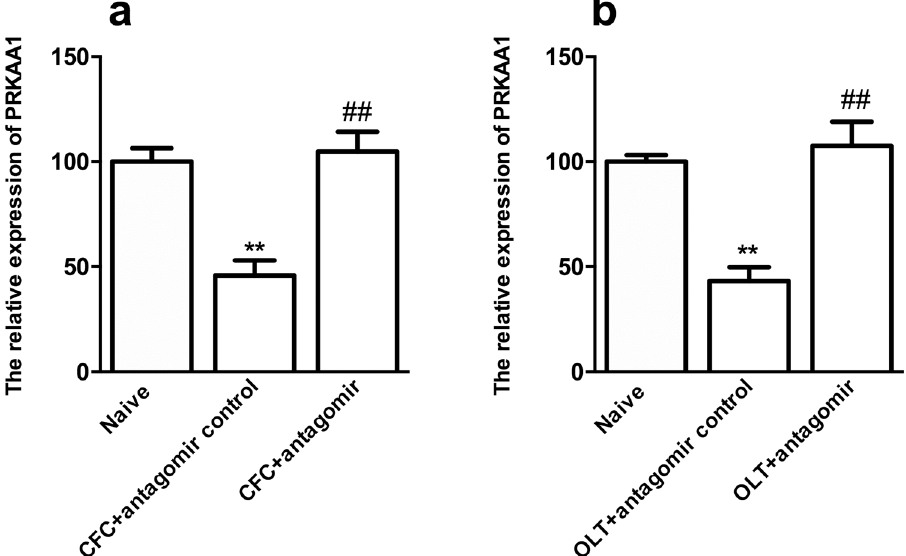
Figure 3. The expression of the PRKAA1 mRNA was regulated by miR-181a during the formation of CFC- and OLT-dependent memories. ( a ) qPCR analysis showing the relative levels of PRKAA1 expression in the mouse DH 2 h after CFC training. ** p < 0.01, compared with the naïve group. ## p < 0.01, compared with the CFC + antagomir control group. ( b ) Relative levels of PRKAA1 expression in the mouse DH 2 h after OLT training. ** p < 0.01, compared with the naïve group. ## p < 0.01, compared with the CFC + antagomir control group. n = 5 per group. All values are presented as means ±